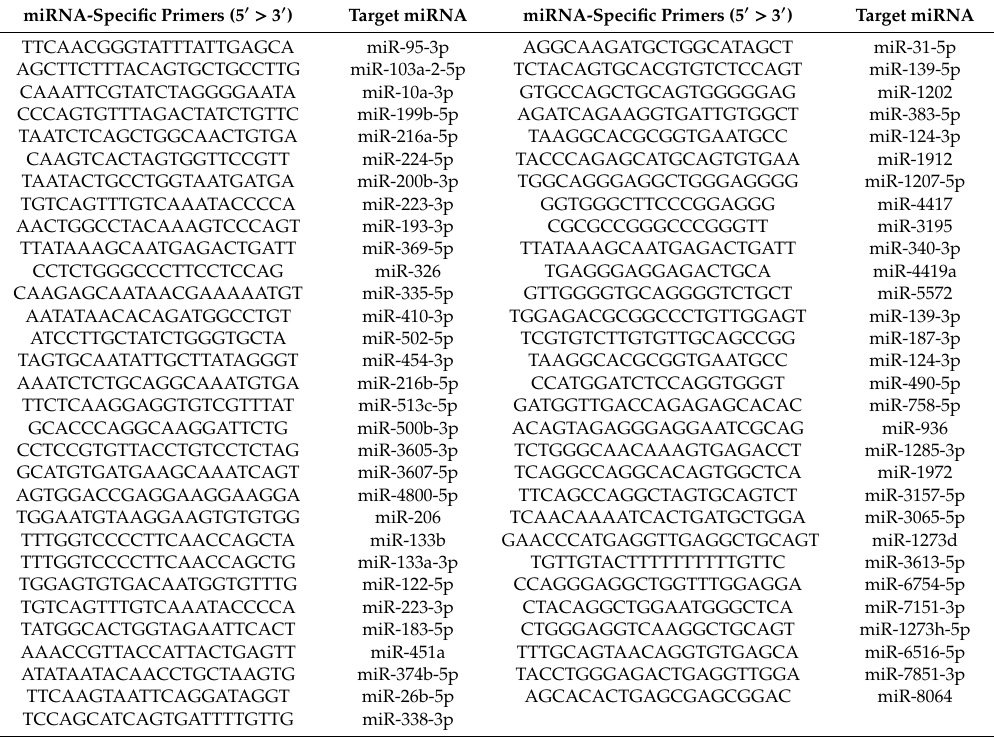
Table 1. Primer list for miRNA expression in real time RT-PCR